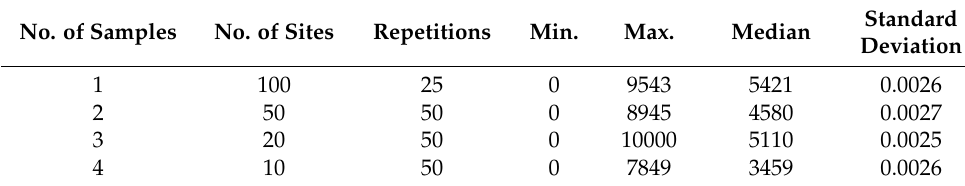
Table 2. Sample data of Monte Carlo simulation.